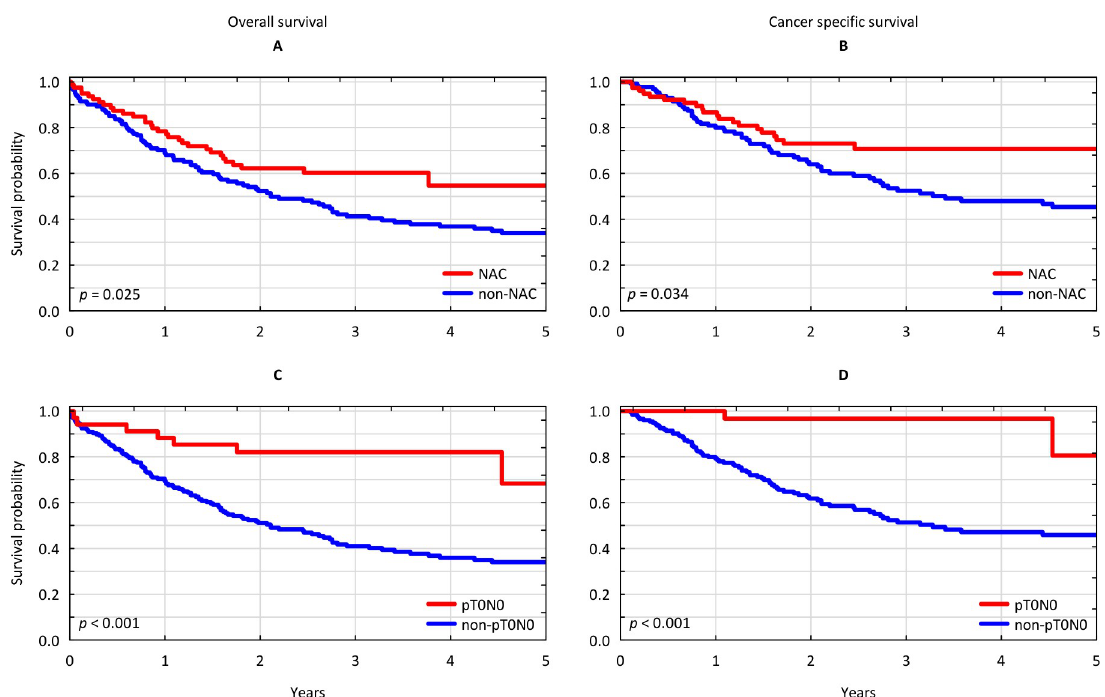
Fig 1. Survival analysis. (A) Kaplan-Meier curves for overall survival stratified by neoadjuvant chemotherapy. (B) Kaplan-Meier curves for cancer specific survival stratified by neoadjuvant chemotherapy. (C) Kaplan-Meier curves for overall survival for patients with complete response (pT0N0) vs those without complete responses (non-pT0N0). (D) Kaplan-Meier curves for cancer specific survival for patients with complete response (pT0N0) vs those without complete responses (non-pT0N0). NAC: neoadjuvant